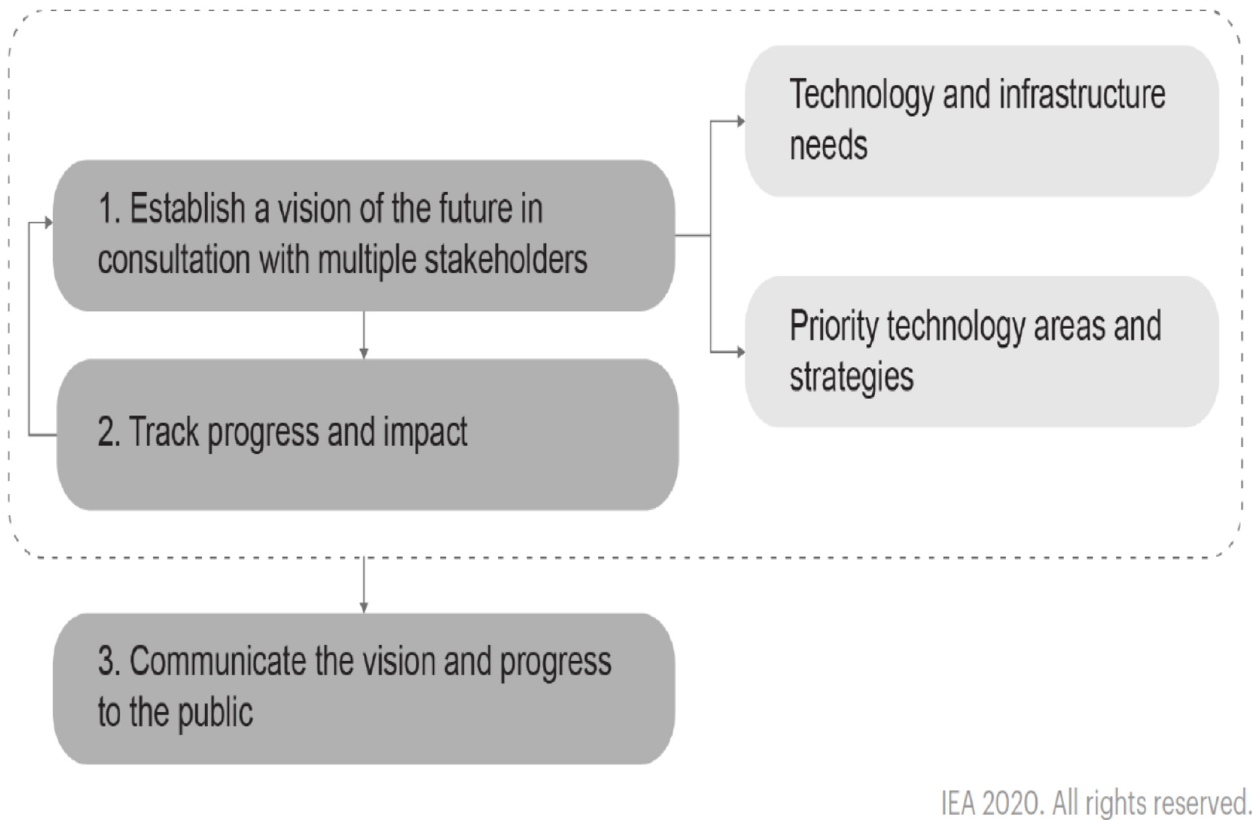
Figure 6. Governing process for a strategy towards net-zero emission [4] and this is similar steps must be used in Energy Village projects.